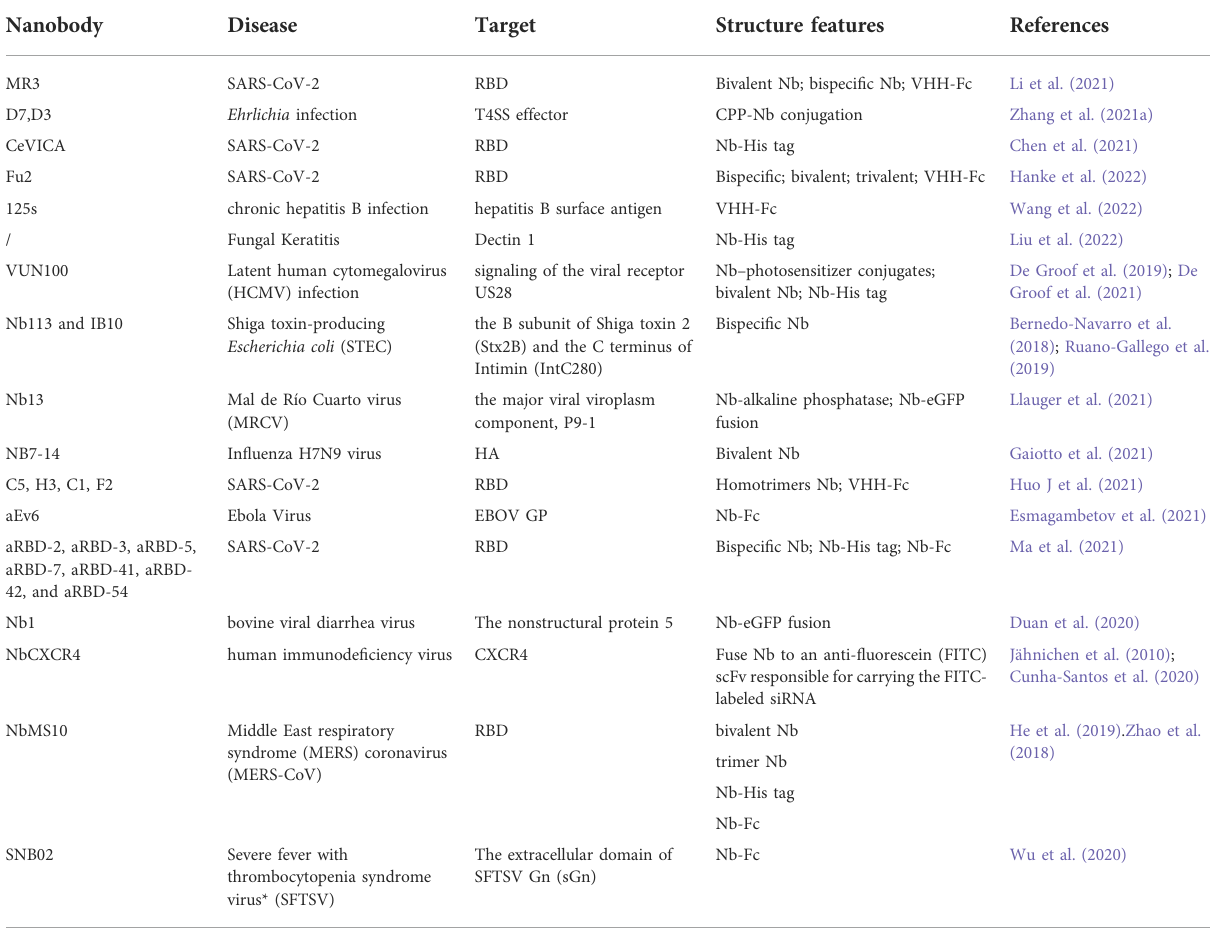
TABLE 1 Representative nanobodies for infectious